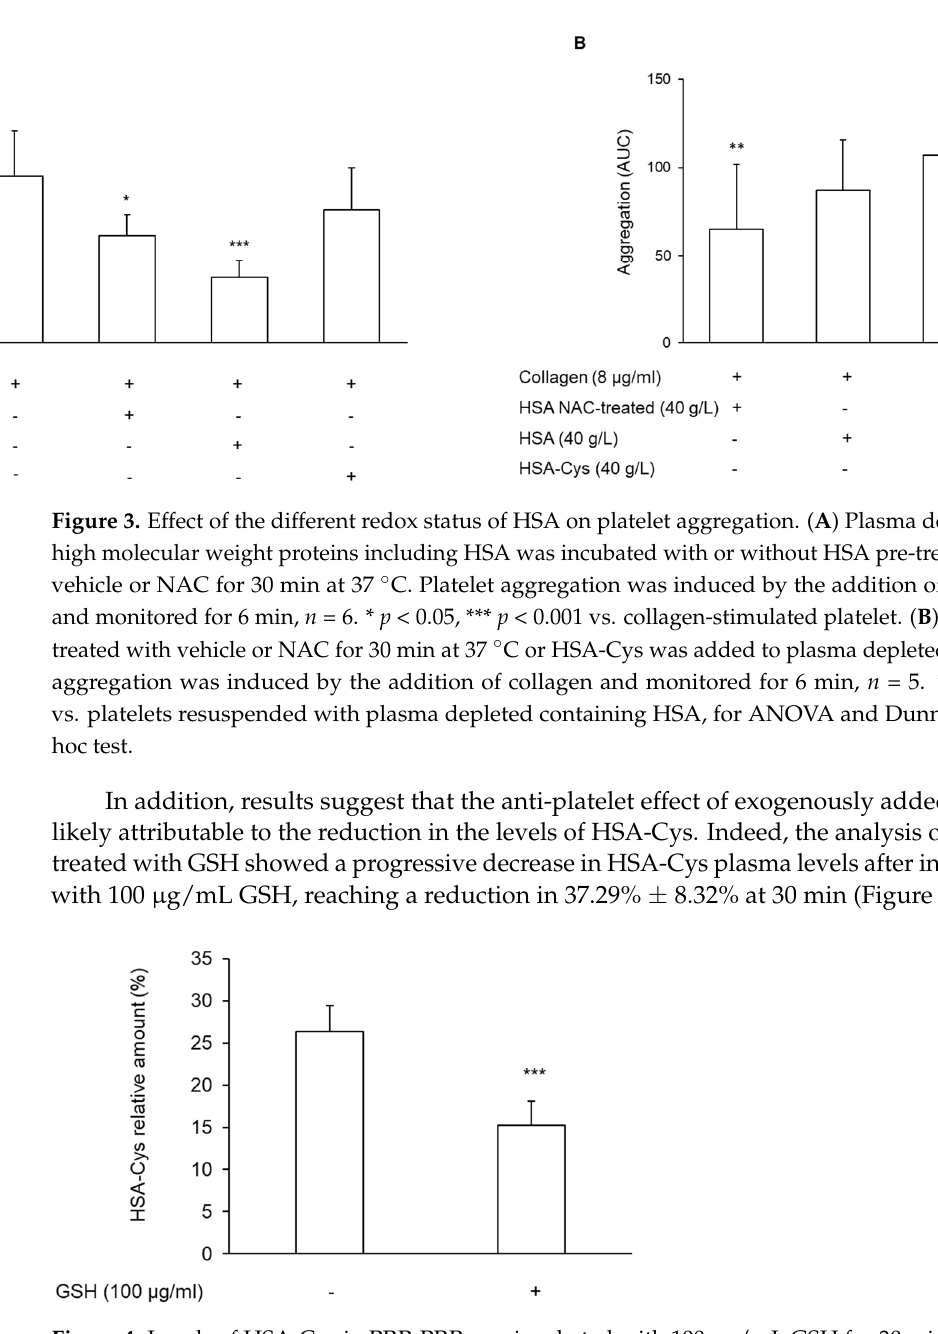
Figure 4. Levels of HSA-Cys in PRP. PRP was incubated with 100 μg/mL GSH for 30 min at 37 °C. Platelets were removed, and the levels of HSA-Cys were measured in plasma mass analysis. n = 6. *** p < 0.001 for Student t -test.